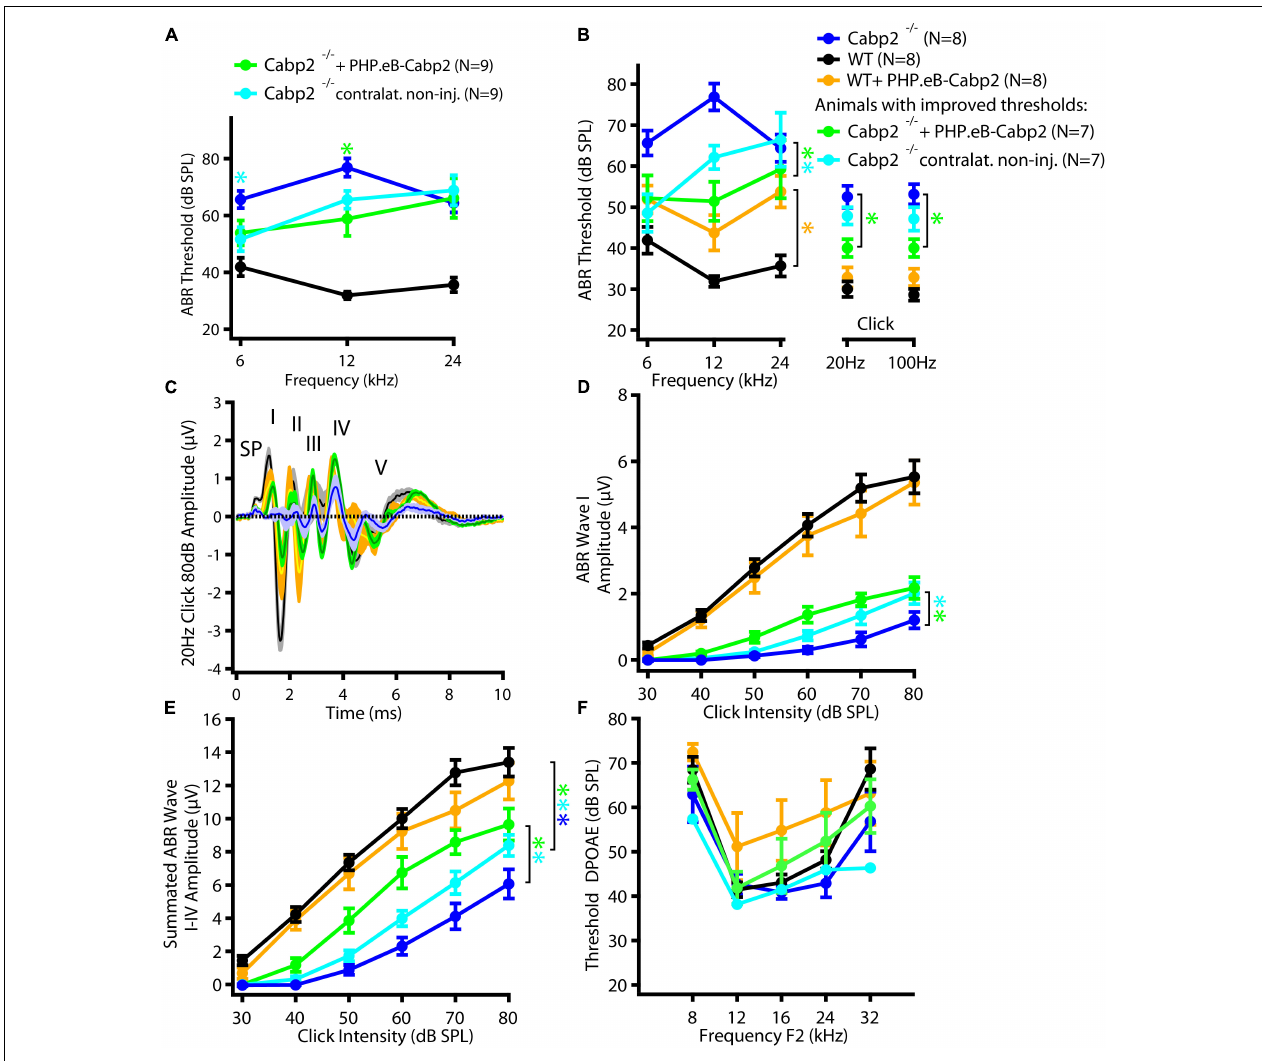
FIGURE 3 | PHPeB-mediated calcium-binding protein 2 ( Cabp2 ) gene transfer improves ABR thresholds and amplitude responses in Cabp2 - / - animals. (A) Mean ABR thresholds of 5-week-old mice plotted as a function of stimulus frequency for WT (black), Cabp2 - / - controls (blue), and Cabp2 - / - mice injected with PHP.eB- Cabp2 (injected ears – green; non-injected contralateral ears – cyan). Partial improvement of hearing was observed in injected Cabp2 - / - mice. See Table 1A for statistical analysis. (B) Seven out of nine injected Cabp2 - / - animals showed hearing thresholds, which were significantly decreased as compared to non-injected Cabp2 - / - animals (six animals) or on the border of significance (one animal). ABR click responses of these animals are displayed in panels (C–E) (see Supplementary Figure 3 for all animals). Overexpression of Cabp2 (or eGFP) in WT animals resulted in increased tone burst ABR thresholds (yellow asterisk).